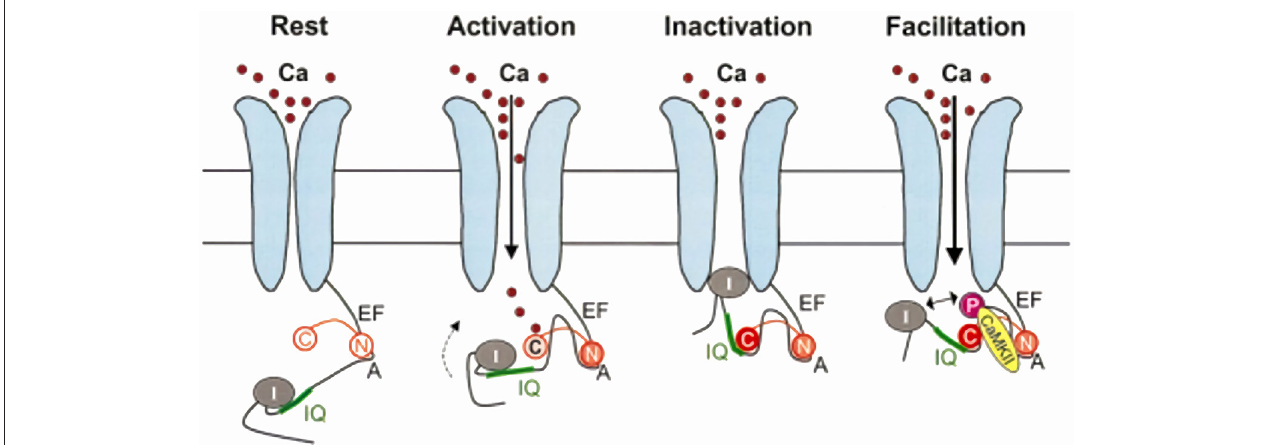
FIGURE 2 | Model for CaM-dependent modulation of Ca v 1.2 channels (I CaL ). CDI mechanism : in the channel closed state (Rest), the N-lobe of apo-CaM (N) is constitutively bound to a pre-IQ region (A) in the channel C-terminus. When the channel opens (Activation), the CaM C-lobe (C) binds to the entering Ca 2 + , which increases its affinity for the channel IQ-domain; this moves the channel inactivation particle (I) in the permeation path (Inactivation). CDF mechanism : holo-CaM binding to CaMKII promotes channel phosphorylation, which results in repulsion of the inactivation particle from the permeation pore (Facilitation). Modified from Maier and Bers